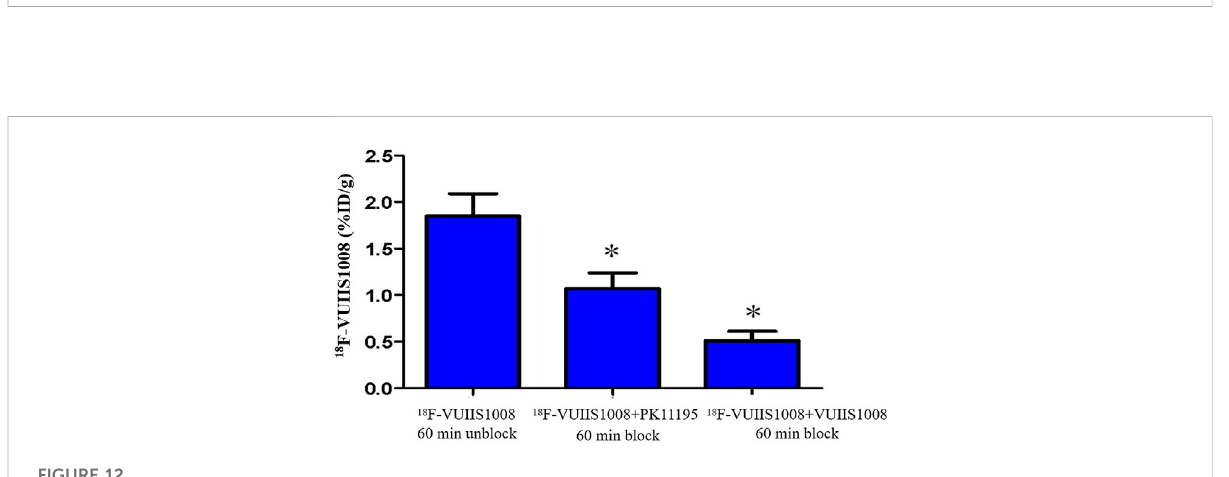
FIGURE 12 Quanti fi cation of 18 F-VUIIS1008 uptake in the left in fl ammatory ankles without and with cold PK11195 or VUIIS1008 blocking.